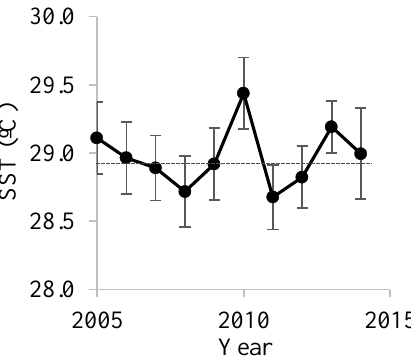
Figure 2. Plots show annual sea surface temperature (SST) with average (±S.E.) from every twelve months data for the period December 2004–November 2014 and average annual SST for the 10-year indicated with a dotted red line drawn from IGOSS data [24].